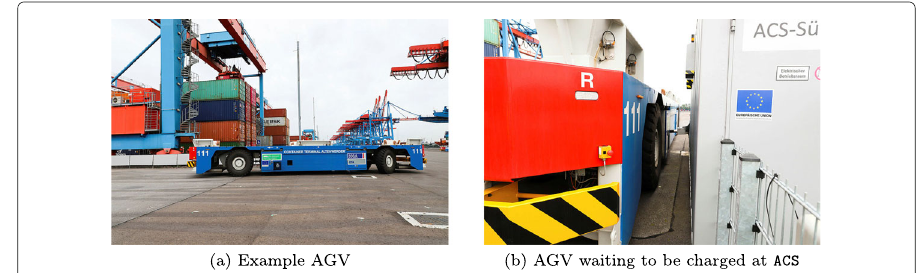
Fig. 2 Battery-electric Automated Guided Vehicles (AGV) and Automated Charging Stations ( ACS ) are the backbone of electrified container transportation at CTA. Images provided by and copyright with HHLA